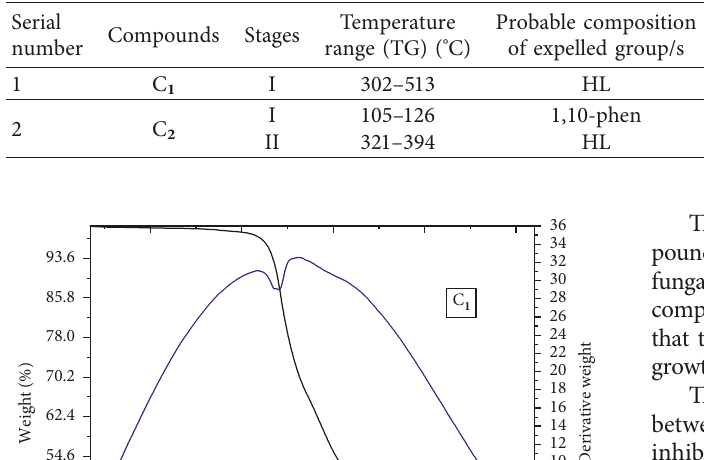
Table 3: TGA analysis of synthesized compounds.